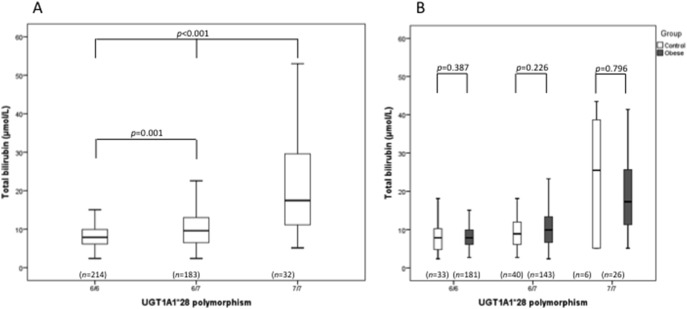
Total bilirubin levels in all participants according to the number of TA repeats in the promoter region of UGT1A1 gene (A) and also according to group (B), control and obese.The boxes represent the interquartile range (IQR), with the upper and lower edges of the boxes representing the 75th and 25th percentiles, respectively. The central horizontal lines within the boxes represent median levels for each group. The vertical whiskers above and below the boxes represent the range of outlying data points up to 1.5 times the IQR.